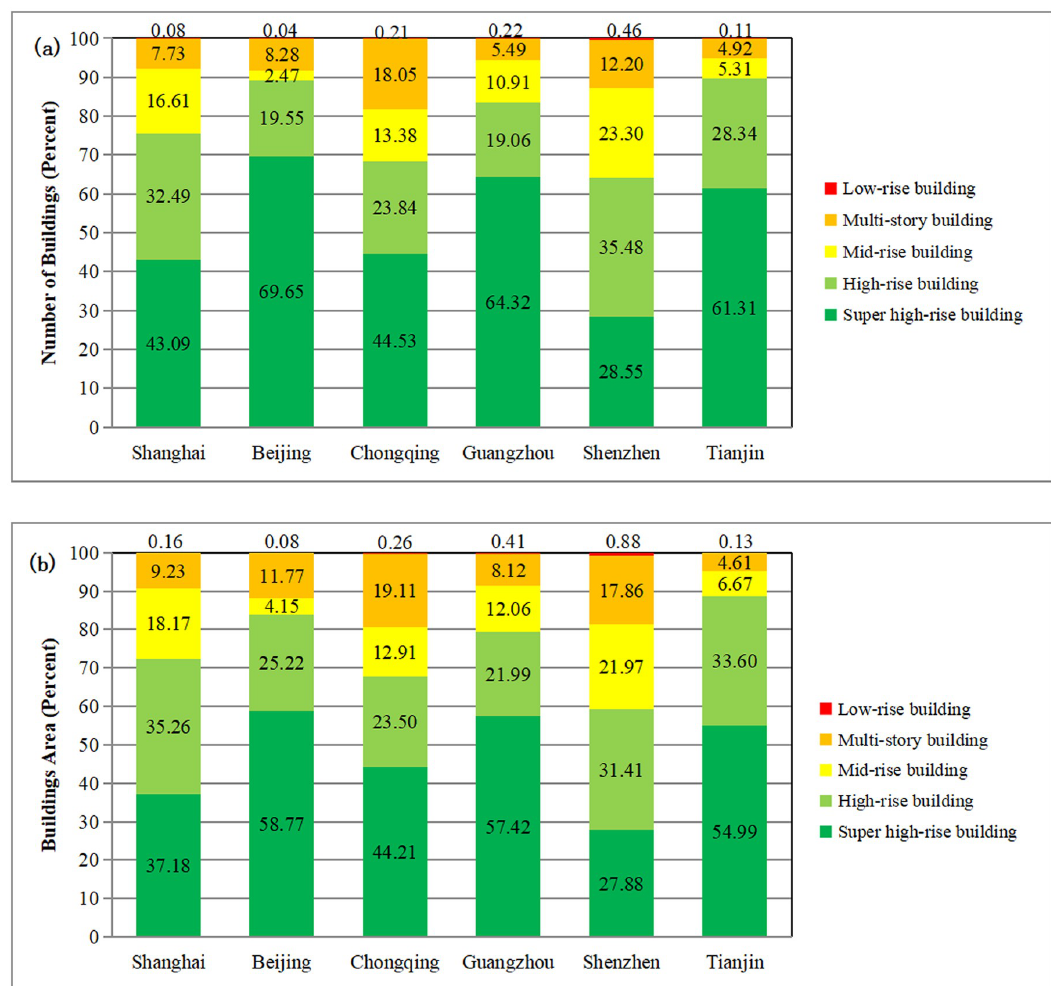
Fig 3. Histograms showing: Numbers percent of buildings according to height (a) and building area ratio (b).